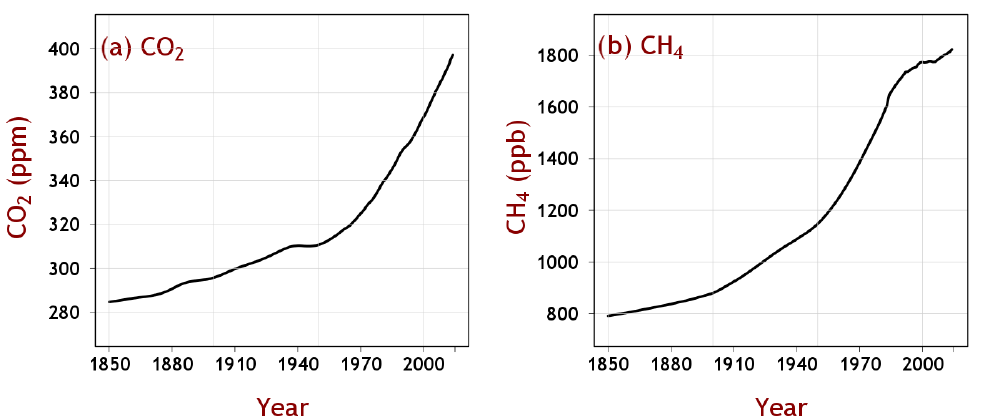
Figure B2. Globally averaged CO 2 and CH 4 concentrations used to drive the CLASS-CTEM